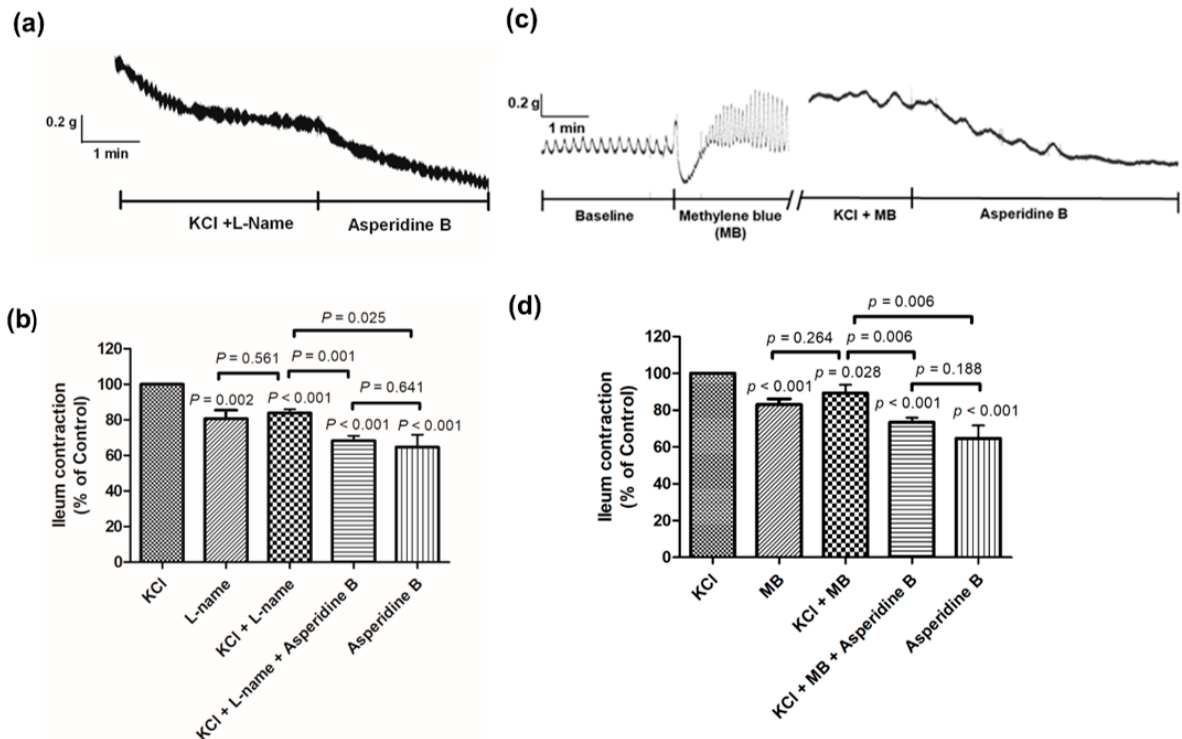
Figure 6. Effect of asperidine B on rat ileal contractions induced by KCl in the absence or presence of ( a , b ) L -NAME ( n = 6) or ( c , d ) methylene blue ( n = 6–9). The differences of the tested compounds except specific comparator indicated that it compared with KCl.